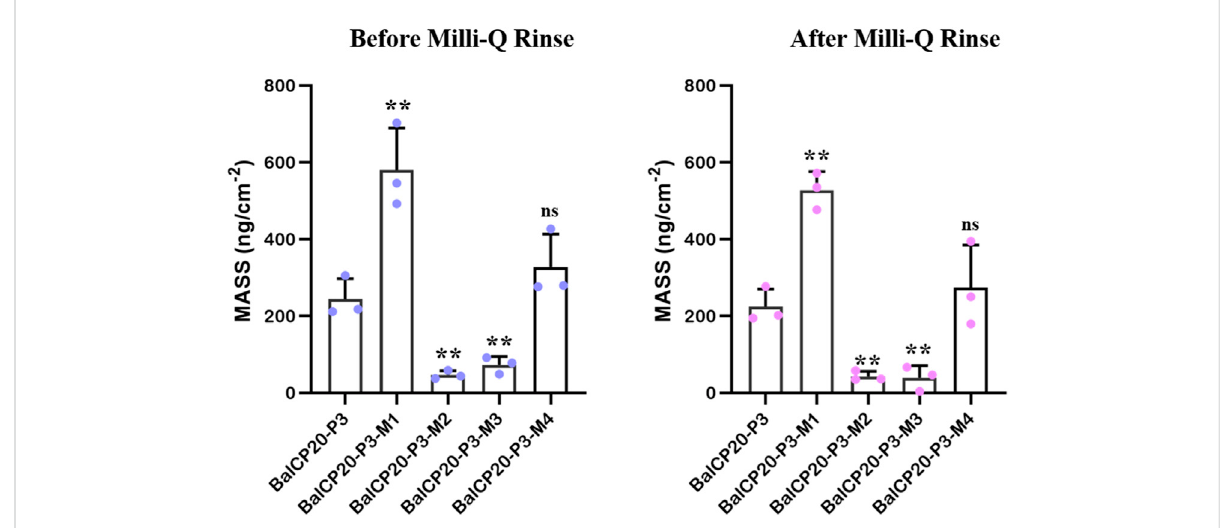
FIGURE 6 Unit area adsorption amount ofBalCP20-P3and its mutants on gold-coated quartz crystal sensors.Data are presented as meanvalues±SDfor n = 3 independent experiments. p -values (from a two-sided unpaired t -test): * p < 0.05; ** p < 0.01; *** p < 0.001; all groups are compared to BalCP20-P3.